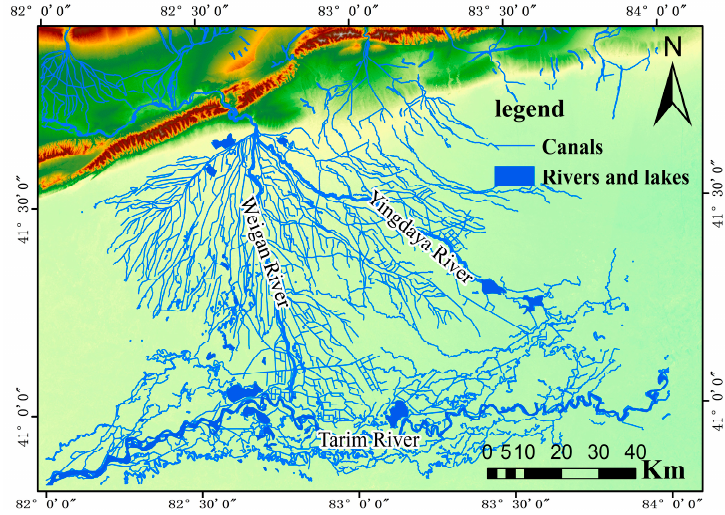
Figure 8. Distribution of Weigan River Basin oasis water system.